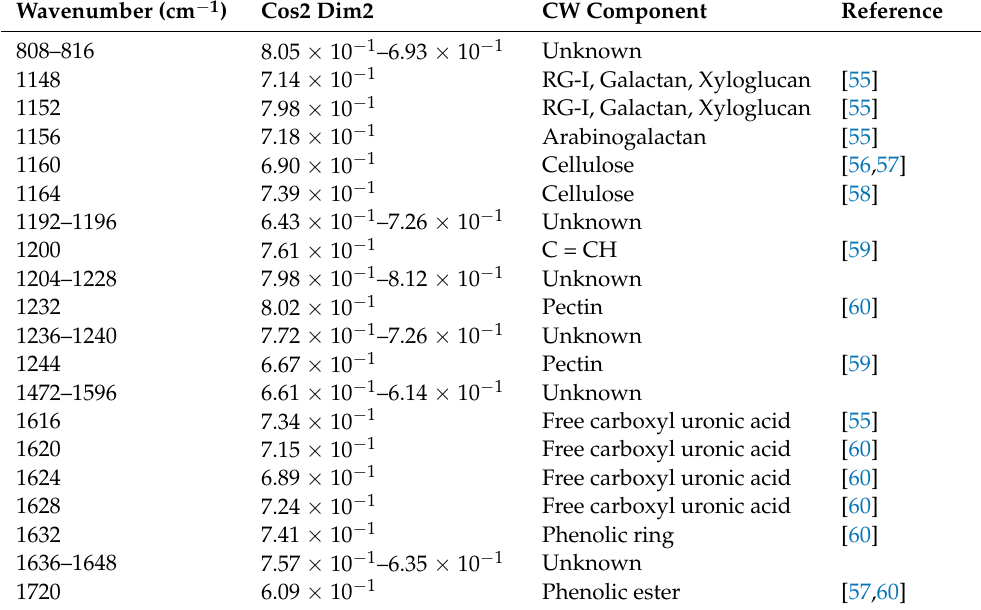
Table 1. FTIR wavenumbers (cm − 1 ) with highest contribution to explain Dimension 2 as Cos2 Dim2 (Figure 1) and the CW component to which they are associated.